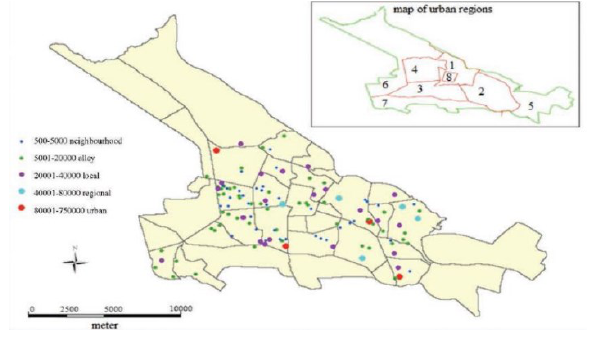
Figure 26. Park Distribution in Different Districts of Tabriz in 2006 (Abizadeh and Zali, 2013).